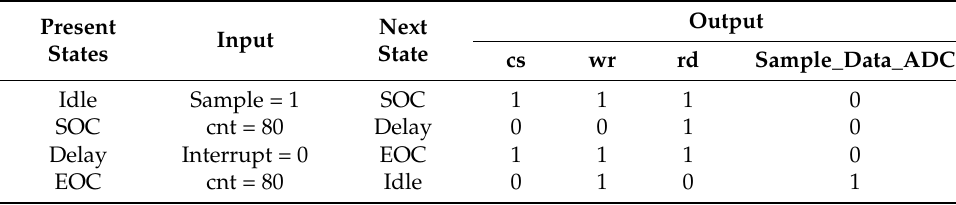
Table 4. ADC Data Acquisition state